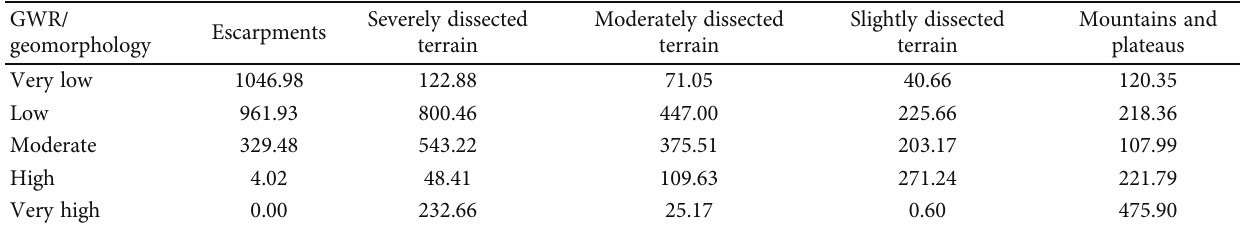
Table 17: Cross-tabulation between GWR and